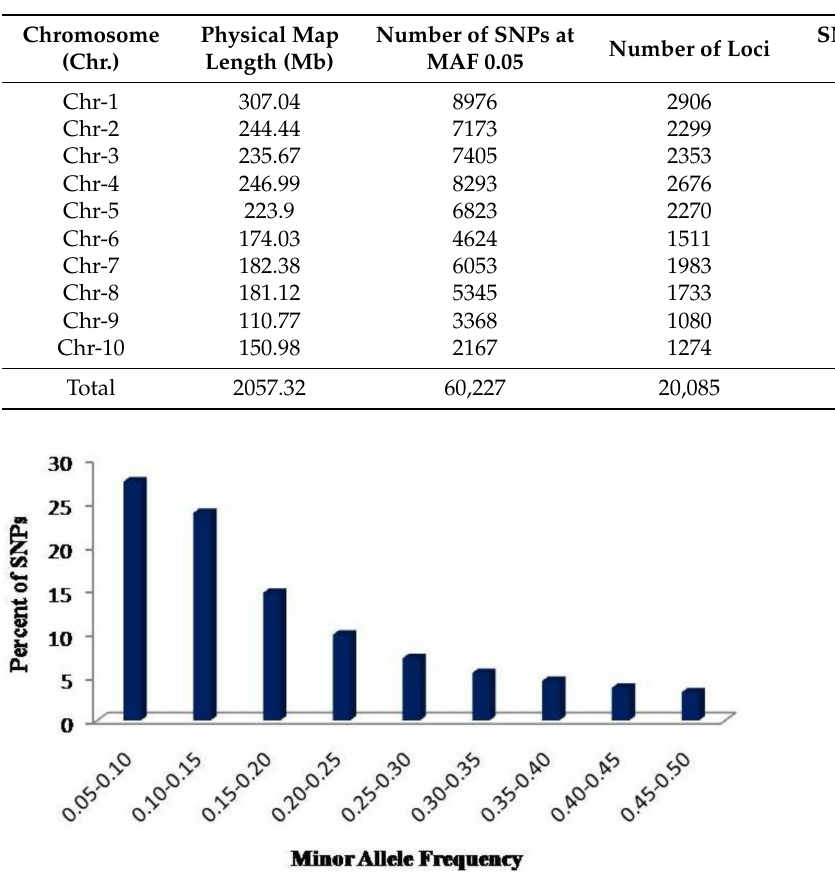
Figure 1. Frequency distribution of the 60,227 polymorphic SNPs by minor allele frequency. The 60,227 polymorphic SNPs cover 2057.3 Mb of the maize genome with each chro- mosome ranging in length from 110.77 Mb (Chr-9) to 307.0 Mb (Chr-1) with an average of 205.73 Mb per chromosome (Figure 2). The total physical distance covered during sequencing accounted for 89.4% of the total B73 genome (2300 Mb) [29]. The polymor- phic SNPs provided the whole genome-wide coverage with a SNP at a mean distance of 34.20 kb (Figure 2). The average physical distance of SNPs on each chromosome ranged from 29.78 kb on Chr-4 to 69.67 kb on Chr-10. As shown in Table 2, the mean nucleotide diversity, frequency of polymorphic sites per bp, and proportion of heterozygous loci observed in the data set were 0.28, 0.02, and 0.17, respectively. The average polymorphic information content (PIC) for 60,277 SNPs was 0.23. DQL 574-2, DQL 609-5, DQL 790-2-4 Analysis of various mutational changes in the sequenced data revealed that the percentage of transition mutations was much higher (72.56%) than that of the transversion (27.44%). The frequency of SNP mutation C/T was highest (0.36), whereas C/G was lowest (0.05). The genome-wide mean transition to transversions ratio was 2.64. Overall, the frequency of C/T and A/G transitions was almost similar (~0.36) in the genome, whereas among transversions, the frequency of G/T was highest (0.076), while C/G was the lowest (0.05). In the case of transversion mutations, the frequencies of A/T, A/C, G/T were near similar (0.073 to 0.076), except the C/G (0.05) (Table